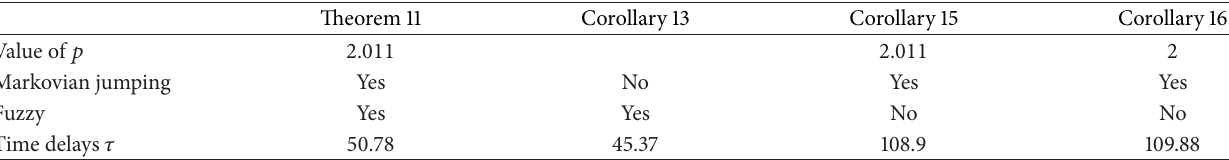
Table 1: Allowable upper bound of 𝜏 for various cases.